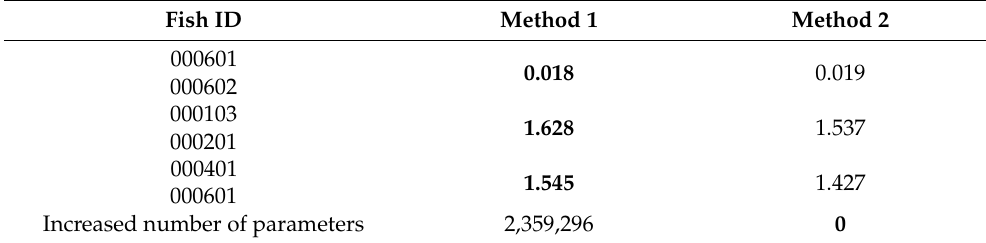
Table 3. The influence of deformable convolution on individual fish